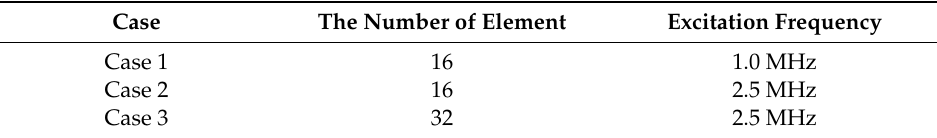
Figure 8. Comparison of B-scan and wavenumber imaging in three cases in rail B. Case one: ( a ) is pulse-echo responses, ( d , g ) are the images of the full matrix, h i , j ( t ) and f i , j ( t ) ; Case two: ( b ) is pulse-echo responses, ( e , h ) are the images of the full matrix, h i , j ( t ) and f i , j ( t ) ; Case three: ( c ) is pulse-echo responses, ( f , i ) are the images of the full matrix, h i , j ( t ) and f i , j ( t ) . Table 2. The selection of di ff erent parameters of the